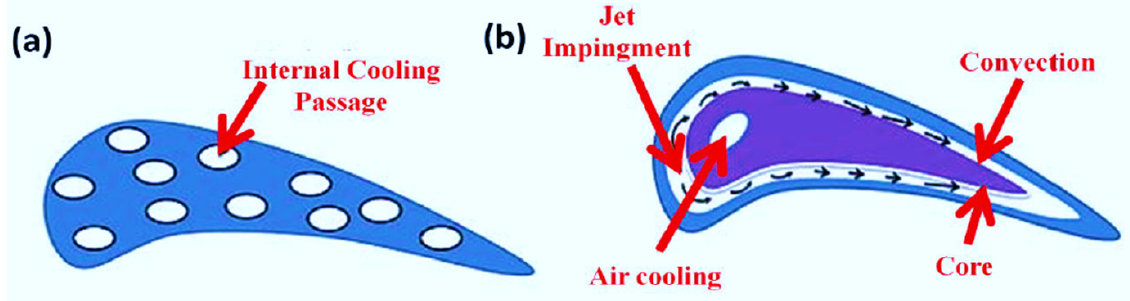
Figure 3. Blade cooling design by ( a ) the convection technique and ( b ) impact cooling [21].